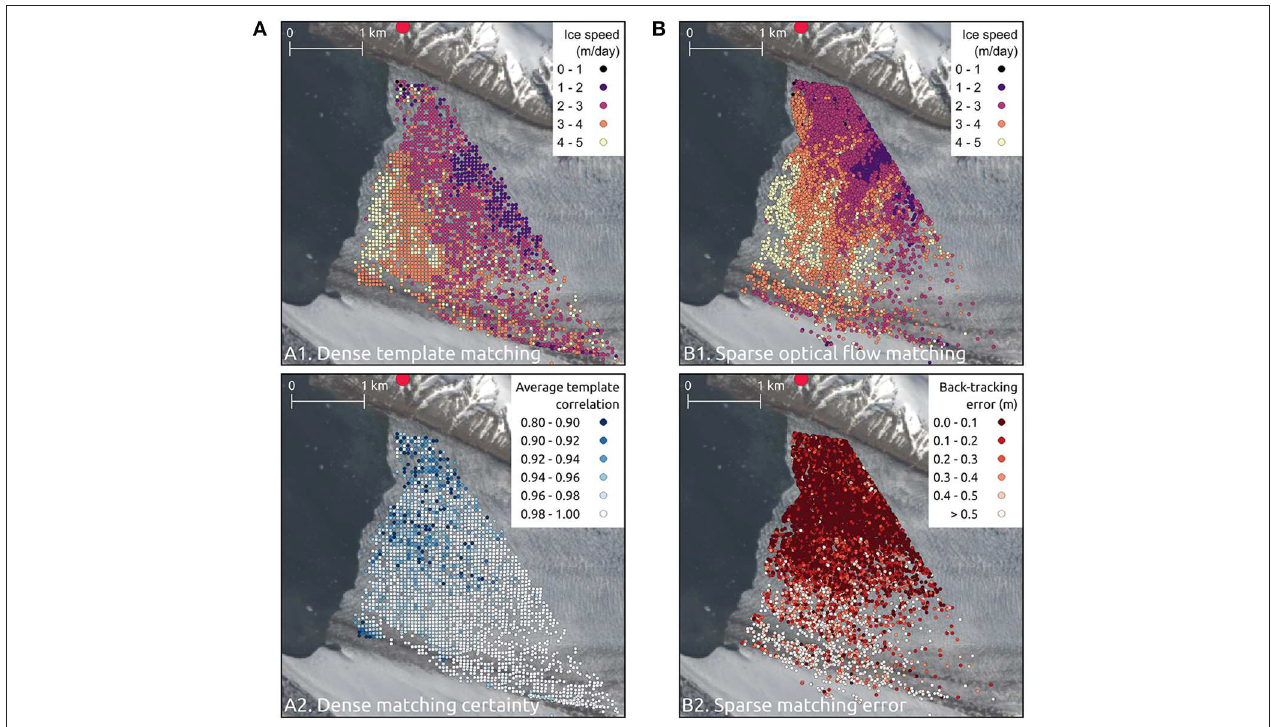
FIGURE 7 | PyTrx’s dense template matching method (A) and sparse Optical Flow matching method (B) implemented on an image pair (28–30 June) from Kronebreen camera KR2 (A1,B1) , including measures of error for each approach (A2,B2) . The velocities derived from these two methods are plotted onto a coinciding Landsat 8 satellite image. Velocities are calculated over a regular grid using the template matching method, providing a good basis for subsequent operations such as interpolation (A1) . 2,826 of 2,854 templates were successfully matched between the image pair in this example. The correlation of each template matched between an image pair is a reliable measure of certainty (A2) ; in this example, the average template correlation between the image pair was 0.97. The Optical Flow method produces a high concentration of velocity measurements in areas of high corner coherency. 16,181 templates were matched in the example in (B1) , with a high concentration of corner templates generated across the crevasse field nearest to the camera (B1) . Matching errors are identified using back-tracking verification, where the difference between an original template and its back-tracked position provides an absolute error value. In (B2) , the average difference between the position of a template and its back-tracked position is 0.15